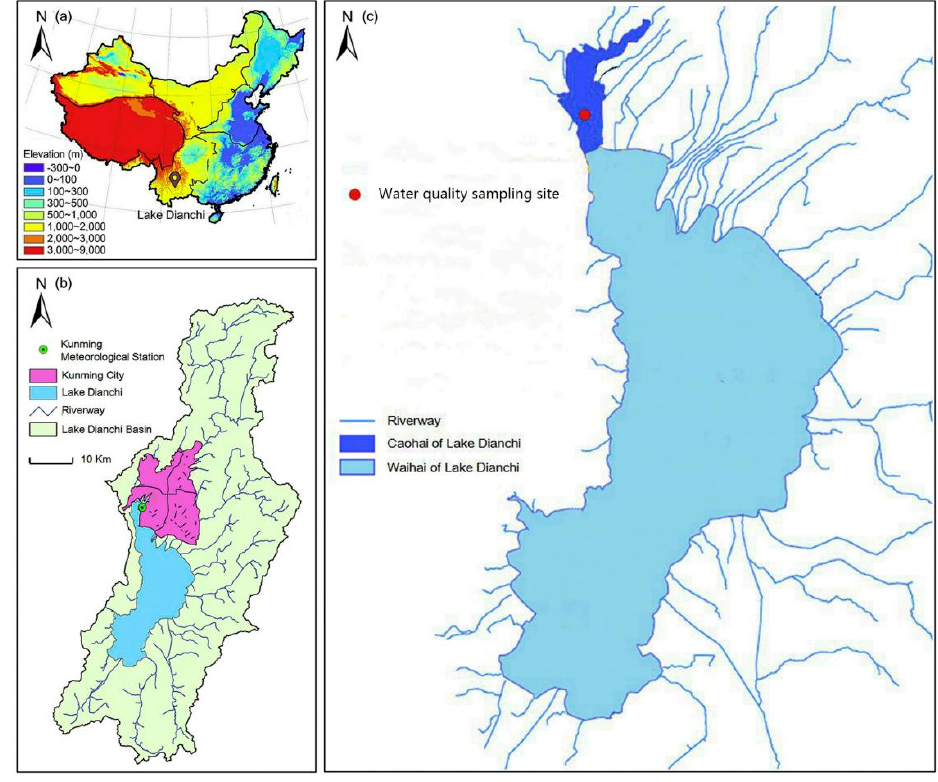
Figure 1. Map of Dianchi Lake watershed.